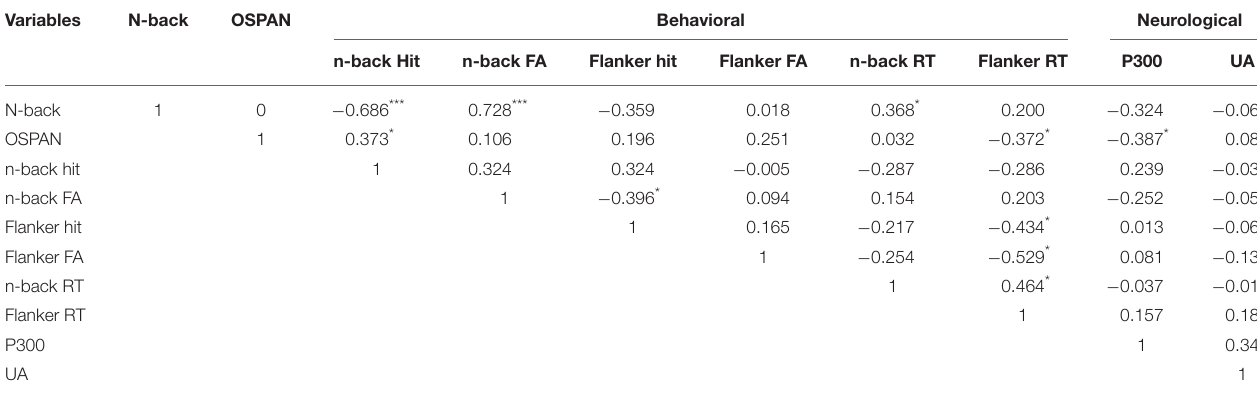
TABLE 4 | Correlation between n-back difficulty level, OSPAN score, behavioral data and neurological data (Pearson’s correlation coefficient). Variables